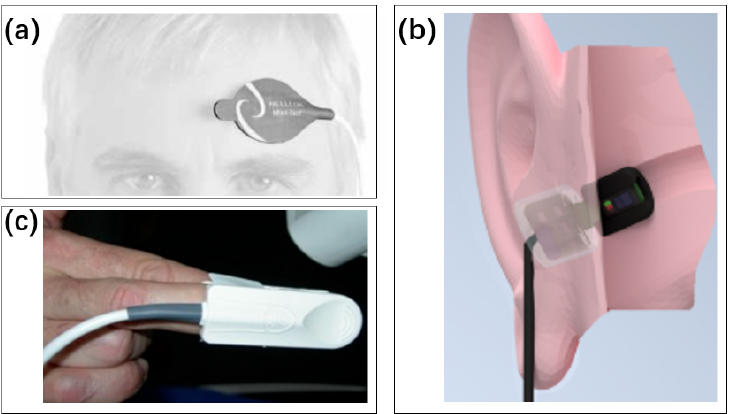
Figure 17. Positioning of the pulse oximeter sensor. ( a ) Forehead [224]. Reproduced with permis-